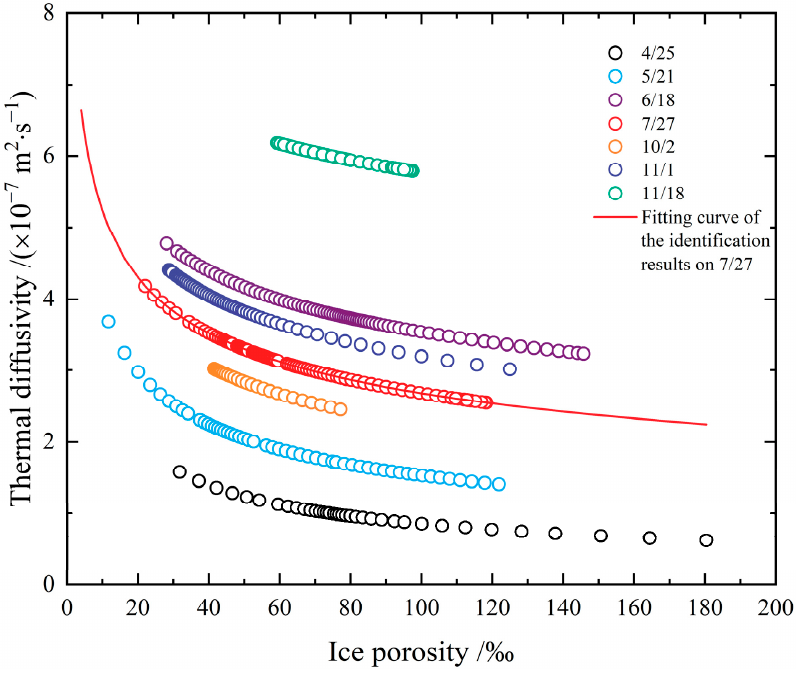
Figure 6. Relationship between inversion-identified thermal diffusivity and porosity of sea ice survey data at Zhongshan Station, Antarctica, in 2006 (modified from Refs. [36,37]).